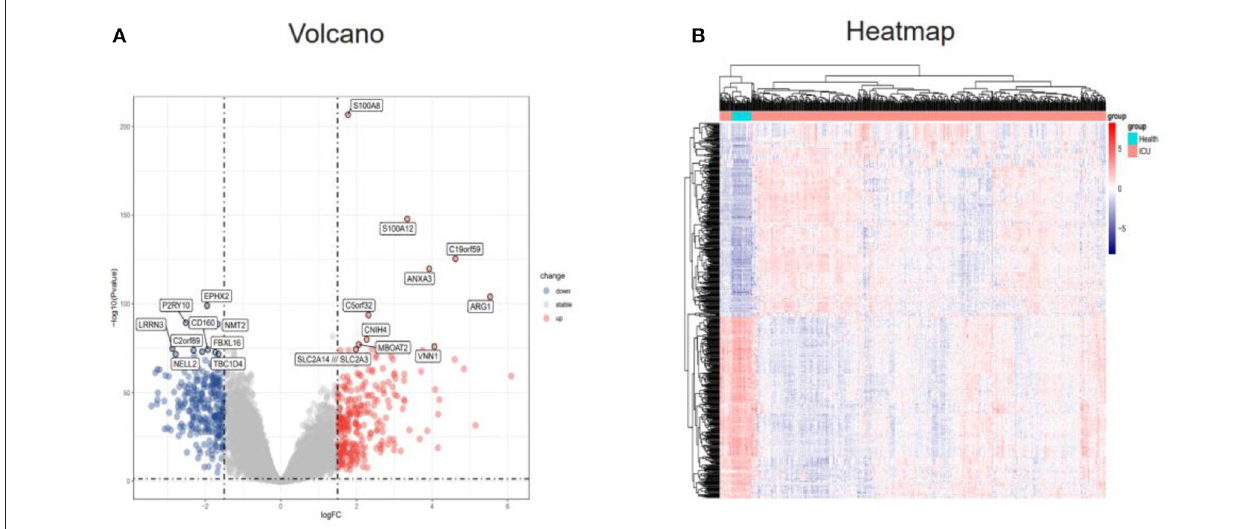
FIGURE 2 | Identification of DEGs in the GSE65682 dataset. (A) Volcano plot of the DEGs (|logFC| > 1.5 and adjusted P-value l < 0.05) in GSE65682. Upregulated genes are in red, and downregulated genes are in blue. (B) Heatmap of the DEGs in GSE65682. DEGs, differentially expressed genes.